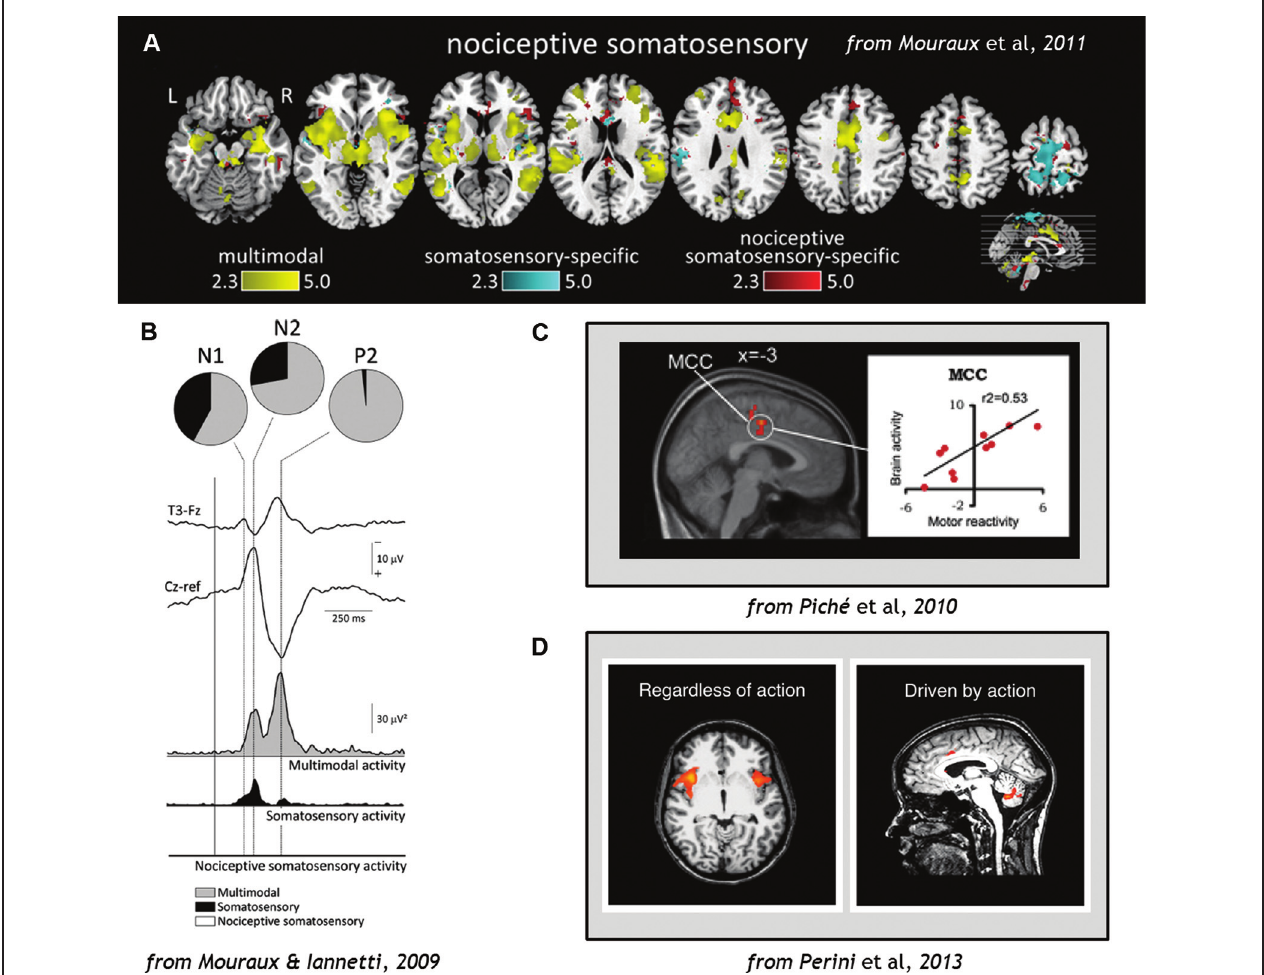
activity, but limited nociceptive-specific activity (Fuster, 1991). (C) fMRI evidence demonstrating correlations in regions of midcingulate cortex (MCC) with individual motor reactivity in the spinal RIII reflex (top) and variance in autonomic arousal (bottom) during electrical pain stimulation (Bancaud et al., 1976). (D) fMRI evidence demonstrates that midcingulate but not anterior insula activations during pain are contingent on motor processing (Duerden and Albanese, 2013). Figures reproduced with